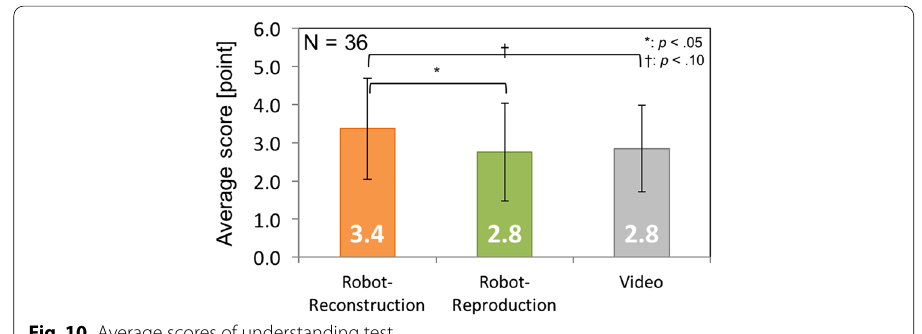
Fig. 10 Average scores of understanding test